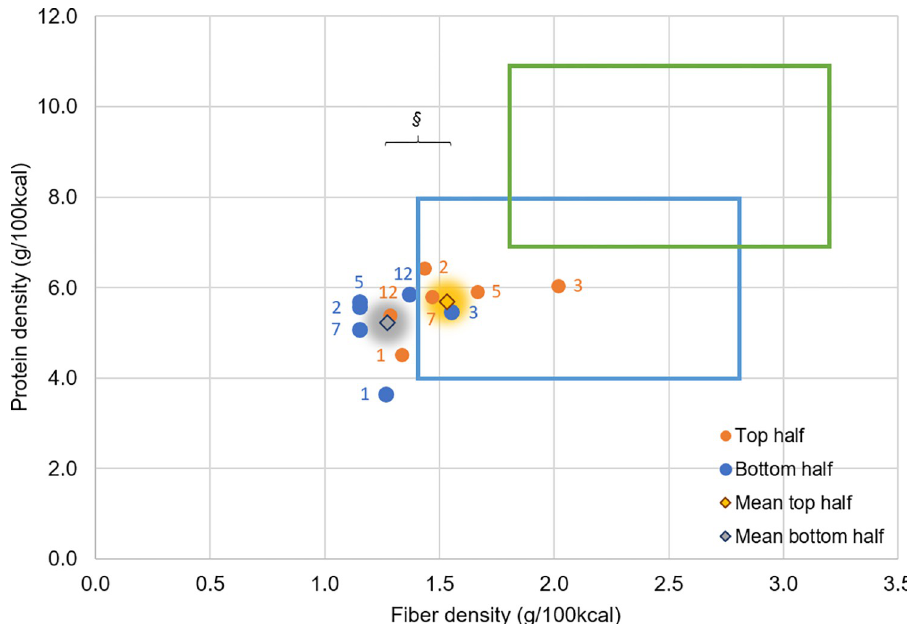
Fig 7. Changes in protein and fiber density of top and bottom half groups in weight loss at 12 months. Twenty- four-hour records conducted at one, two, three, five, seven and 12 months. Dietary records were divided to two groups based on top half (n = 6) and bottom half (n = 6) of weight loss at 12 months. Data are presented as mean. §p = 0.04 significant difference in fiber density between two groups by repeated measure ANOVA when all time points of 24-hour records were combined (n = 35 for each